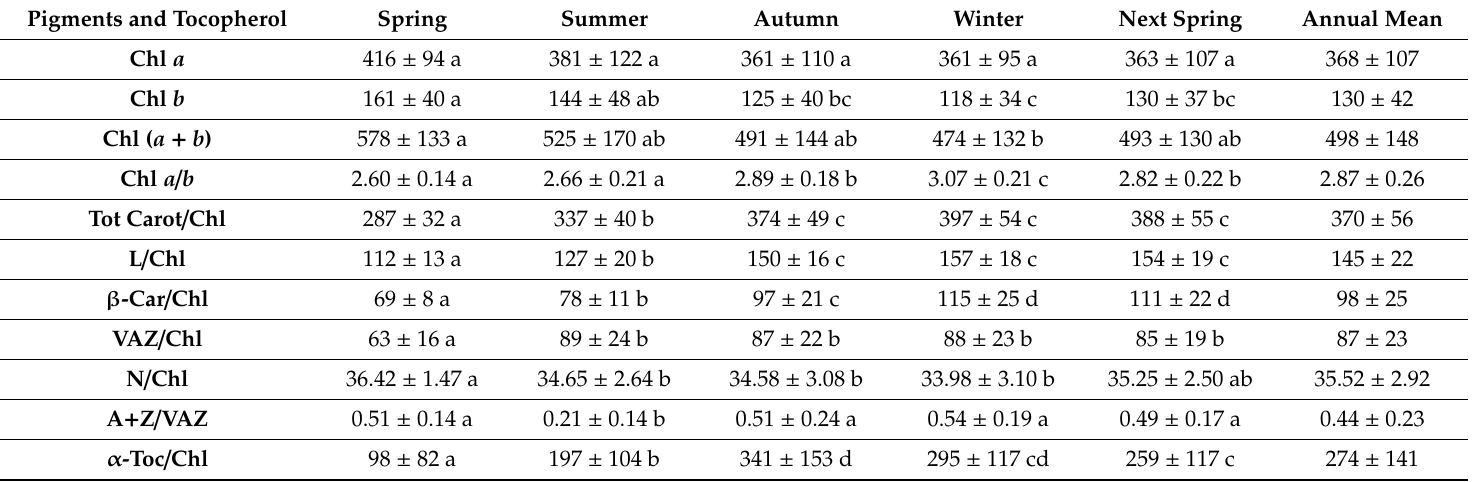
Table 2. Pigment and tocopherol composition in P. canariensis needles (mean ± sd) where: chlorophyll a (Chl a ; µ mol m − 2 ); chlorophyll b (Chl b ; µ mol m − 2 ); total β -Carotene per chlorophyll ( β -Car); Total VAZ (V: Violaxanthin, A: Anteraxanthin, Z: Zeaxanthin) per chlorophyll (VAZ / Chl); Neoxanthin per chlorophyll (N / Chl); Anteraxanthin and Zeaxanthin to total VAZ ratio (A + Z / VAZ); and α -Tocopherol per chlorophyll ( α -Toc / Chl). All data per chlorophyll are shown in mmol mol − 1 Chl a + b . Di ff erent letters denote statistically significant di ff erences at P < 0.05 after Duncan test over the